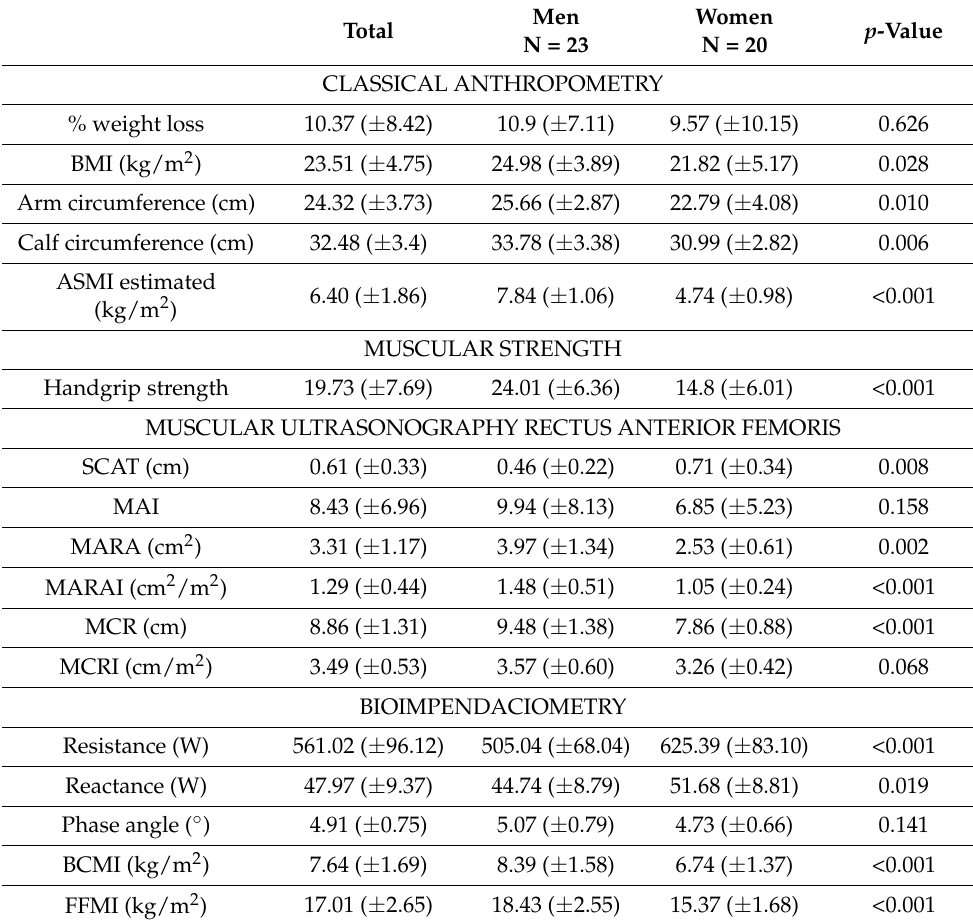
BMI: body mass index, ASMI: appendicular skeletal muscle index, SCAT: subcutaneous adipose tissue, MAI: muscular adipose index, MARA: muscular area rectus anterior, MARAI: muscular area